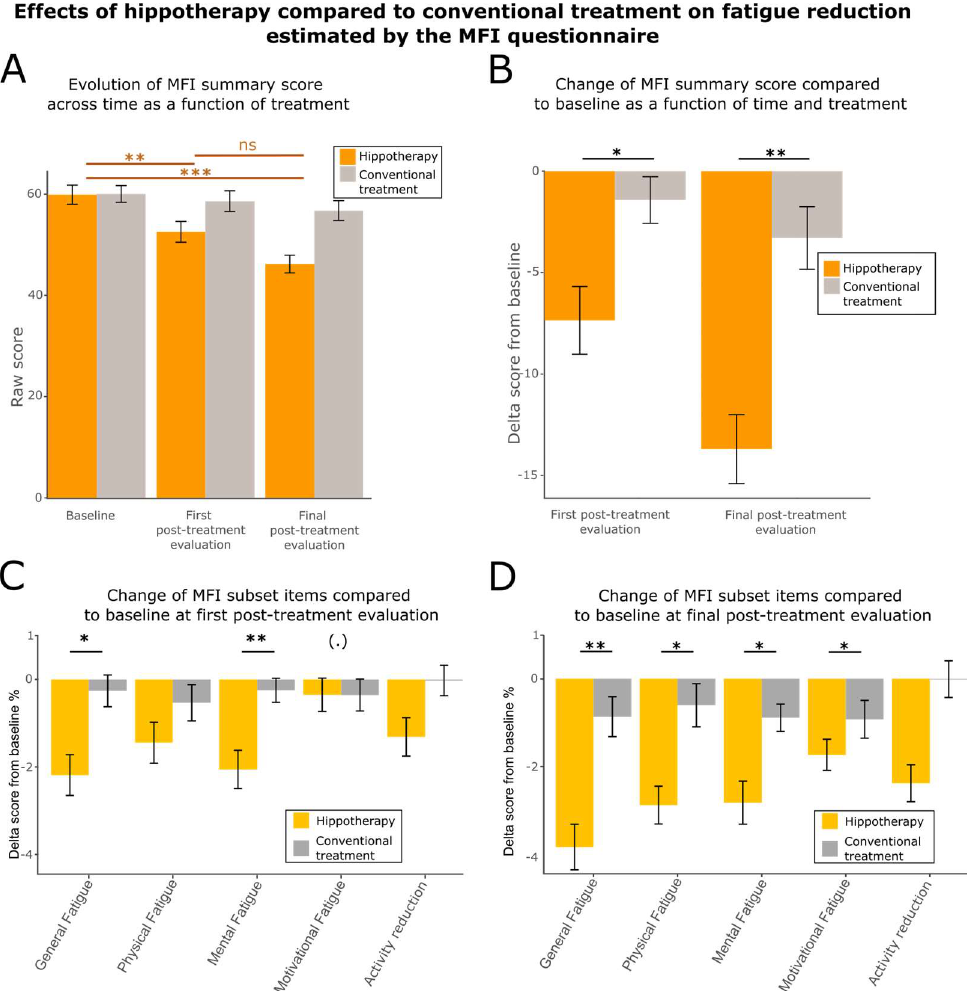
Figure 4. Effects of hippotherapy treatment compared to conventional treatment on fatigue reduc- tion, as estimated by the MFI-20 questionnaire. ( A ) Bar chart represents means (M) and standard errors of means (SEM) of the evolution of MFI-20 summary scores across time, as a function of the treatment type. Values (M ± SD) are as follows: Baseline = 59.9 ± 15.1, First post-treatment evaluation = 52.5 ± 16.5, Final post-treatment evaluation = 46.2 ± 14.0 for the hippotherapy group; Baseline = 60.0 ± 13.3, First post-treatment evaluation = 58.6 ± 16.4, Final post-treatment evaluation = 56.8 ± 15.7 for the control group. ( B ) Change of score compared to MFI-20 baseline score (M ± SEM), as a func- tion of time and treatment. Values (M ± SD) are as follows: First post-treatment evaluation = −7.36 ± 13.3, Final post-treatment evaluation = −13.3 ± 13.6 for the hippotherapy group; First post-treatment evaluation = −1.43 ± 9.22, Final post-treatment evaluation = −3.23 ± 12.5 for the control group. ( C ) Comparison of score changes for the MFI-20 subsets between the two groups at the first post-treat- ment evaluation. ( D ) Comparison of score changes for the MFI-20 subsets between the two groups at the final post-treatment evaluation. (***) p < 0.001; (**) p < 0.01; (*) p < 0.05; (.) close to significance (between 0.08 and 0.05); (ns) non-significant.